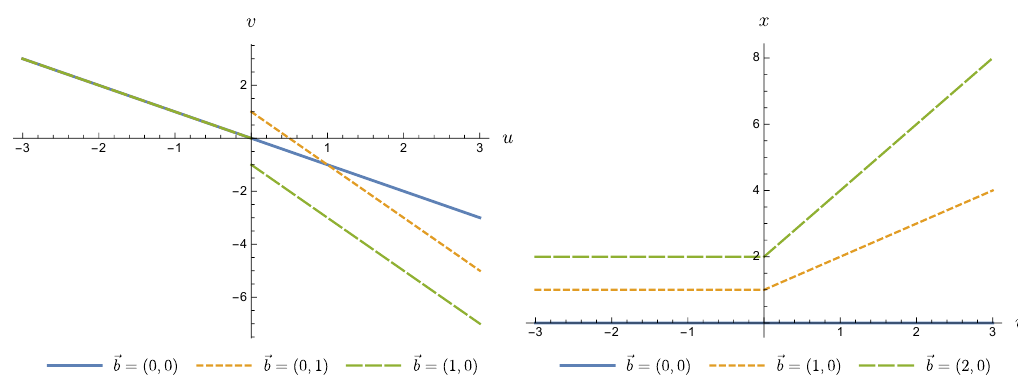
Figure 6 . Geodesics in shockwave spacetime. We display timelike geodesics corresponding to a static trajectory at fixed z 0 = 2 T for different impact parameters ~b . We consider the case where the trajectory has no initial velocity before encountering the shockwave; this corresponds to dx/du = dy/du = 0 , so that C i = 0 , and dv/du = − 1 for u < u 0 . For this trajectory the proper time τ is related to the affine parameter u by a constant shift u = τ − z 0 . The plot for y ( u ) is similar to the x ( u ) plot on the right. Due to the choice of the shockwave profile and coordinate system ( u, v, ~x ) , we see that from the metric (2.1) the static trajectories that lie in the ~b = 0 plane are not affected by the